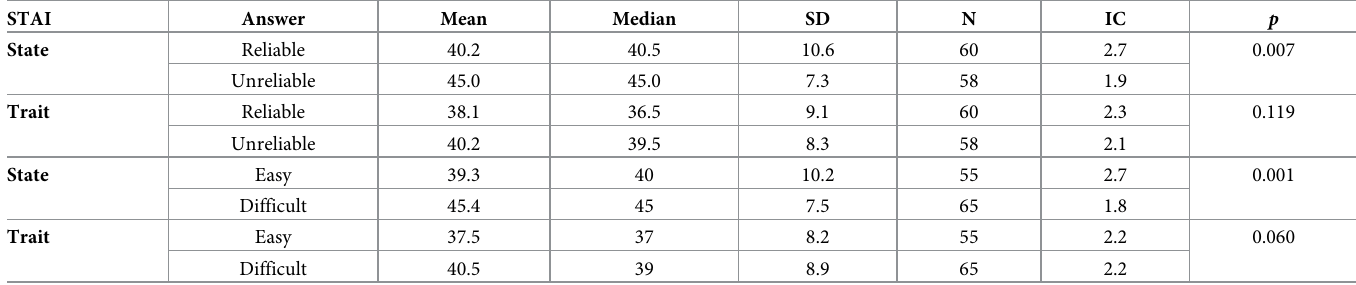
STAI, State -Trait Anxiety